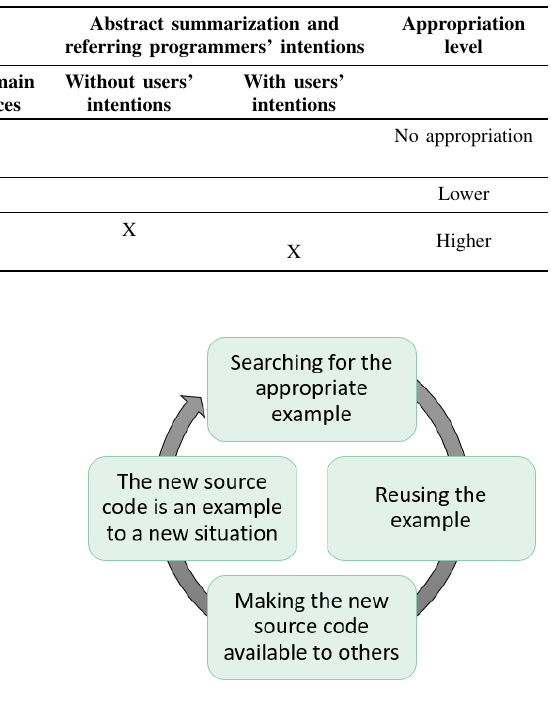
Fig. 5. Examples reuse